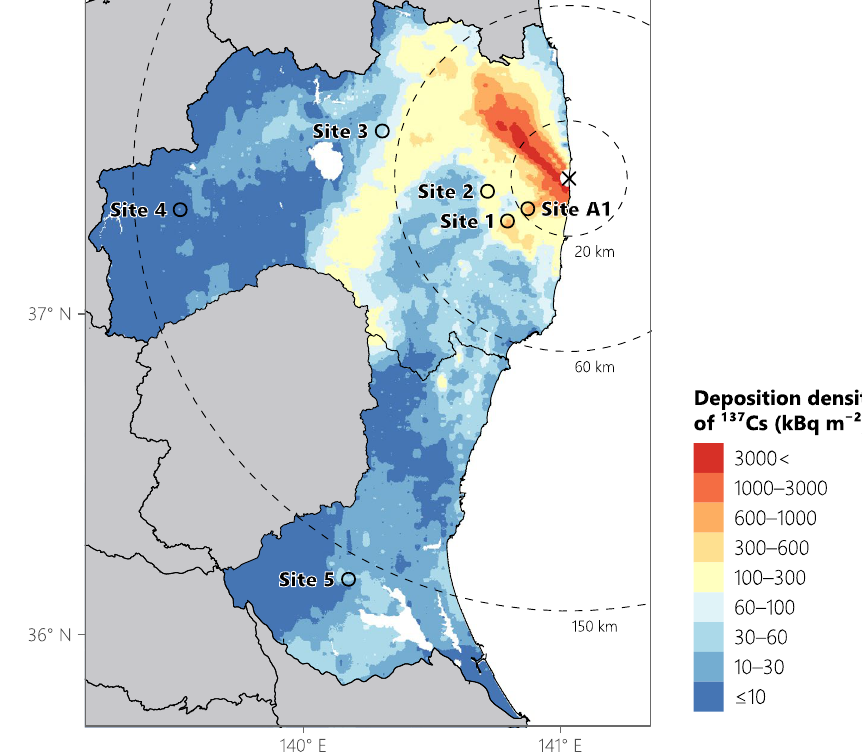
Figure 1. Locations of the monitoring sites and initial deposition densities of 137 Cs (decay-corrected to July 2, 2011) following the Fukushima nuclear accident in Fukushima and Ibaraki Prefectures. Open circles indicate the monitoring sites and the cross mark indicates the Fukushima Dai-ichi Nuclear Power Plant. Data on the deposition density were provided by MEXT 19,20 and refined by Kato et al. 21 . The map was created using R